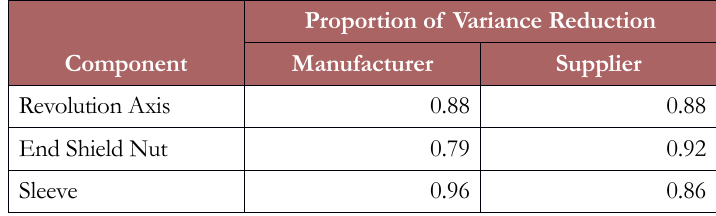
Table 8. Proportion of Variance Reduction at first cycle